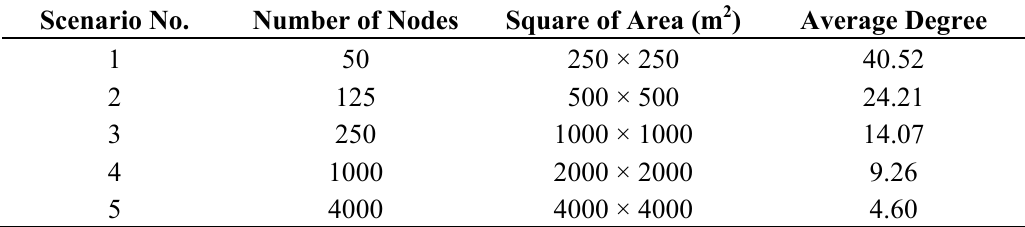
Table 2. Simulation scenarios (communication radius = 110 m).